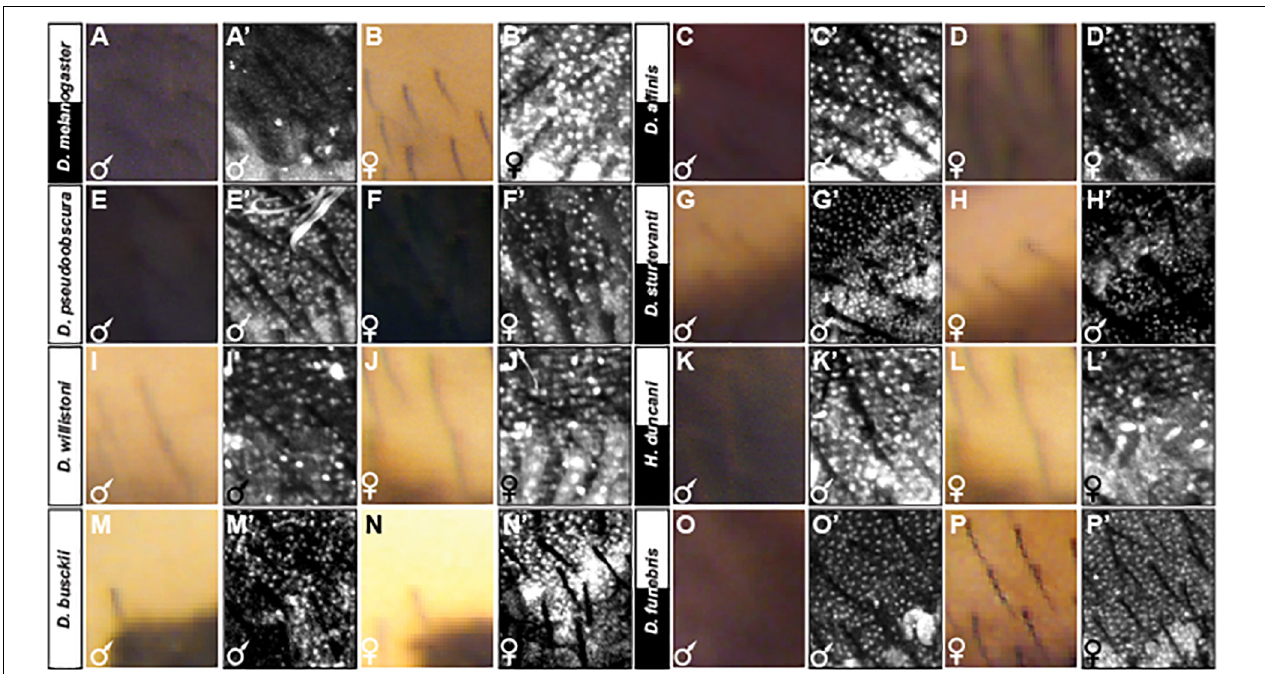
FIGURE 7 | Adult pigmentation phenotypes and P14-P15i stage pupal Bab1 expression in a representative region of the A5 segment. (A) Male and (B) female tergite pigmentation, and (A’) male (B’) female Bab1 expression for D. melanogaster . (C) Male and (D) female tergite pigmentation, and (C’) male (D’) female Bab1 expression for D. affinis . (E) Male and (F) female tergite pigmentation, and (E’) male (F’) female Bab1 expression for D. pseudoobscura . (G) Male and (H) female tergite pigmentation, and (G’) male (H’) female Bab1 expression for D. sturtevanti . (I) Male and (J) female tergite pigmentation, and (I’) male (J’) female Bab1 expression for D. willistoni . (K) Male and (L) female tergite pigmentation, and (K’) male (L’) female Bab1 expression for H. duncani . (M) Male and (N) female tergite pigmentation, and (M’) male (N’) female Bab1 expression for D. busckii . (O) Male and (P) female tergite pigmentation, and (O’) male (P’) female Bab1 expression for D. funebris . Tergite pigmentation is dimorphic for D. melanogaster , D. affinis , D. sturtevanti , H. duncani , and D. funebris . Bab1 expression was dimorphic for D. melanogaster (little to no expression in males), while monomorphic for all other species examined here, including those that exhibit dimorphic